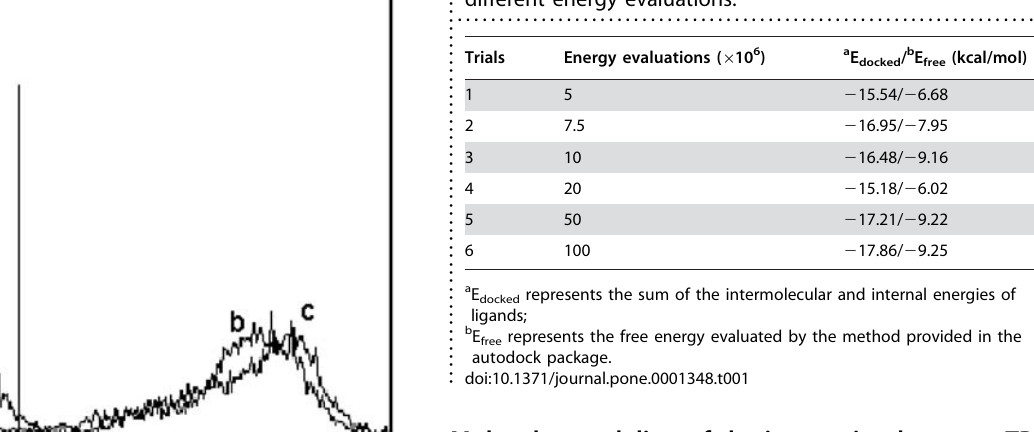
Table 1. Docking energies of six groups of trials